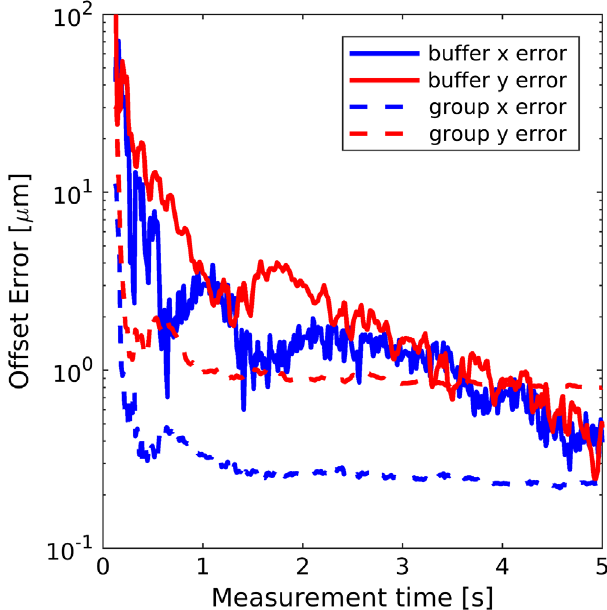
FIG. 10. Measured buffer and group offset errors, averaged over 5 BPMs, as a function of the acquisition time for a (dc) normal quadrupole